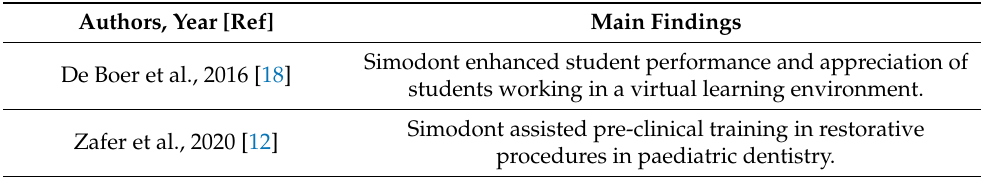
Table 1. Main findings of studies of Simodont in dental